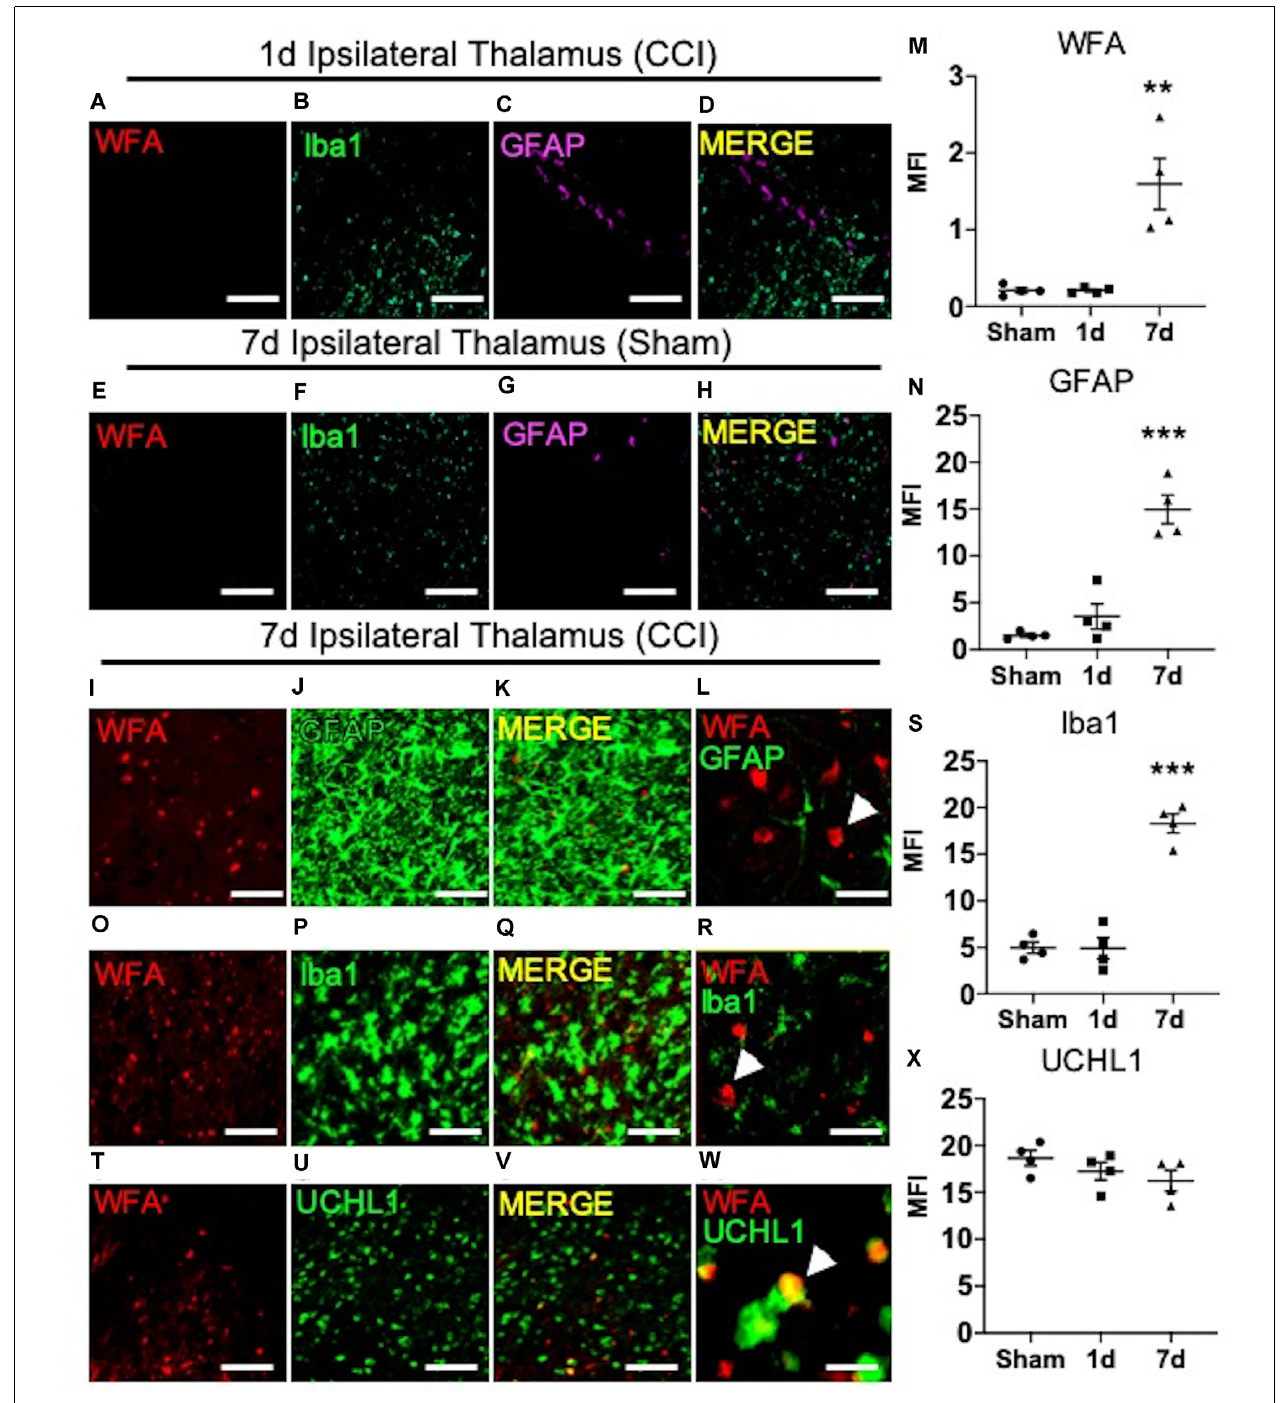
FIGURE 2 | The appearance of thalamic WFA + puncta moderately associates with UCHL1 + neurons 7 days post-CCI. Representative images of the ipsilateral thalamus at 1 day post-CCI show normal expression of WFA (A) , Iba1 (B) , GFAP (C) , and merged image (D) . Representative images of the ipsilateral thalamus at 7 days after the sham procedure show normal expression of WFA (E) , Iba1 (F) , GFAP (G) , and merged images (H) . The appearance of ipsilateral thalamic WFA + puncta (I,O,T) occurred in association with astrogliosis (GFAP, J ; merged image K,L ; quantified in M and N ), microgliosis (Iba1, P ; merged image Q,R ; quantified in S ), and UCHL1 + neurons ( U ; merged image V,W ; quantified in X ). High magnification image shows that GFAP (L) , Iba1 (R) , and UCHL1 (W) weakly colocalized with WFA + puncta in the thalamus ( white arrow demarcates WFA + puncta ). One-way ANOVA Dunnett’s post hoc test (M,N,S,X) . Values represent means ± SD ( n = 4, ** P < 0.01 ; *** P < 0.001 ). Scale bars = 200 µ m (A–K,O–Q,T–V) and 20 µ m (L,R,W) . WFA, wisteria floribunda agglutinin; UCHL1, ubiquitin C-terminal hydrolase L1; MFI, mean fluorescent intensity; CCI, controlled cortical impact; GFAP, Glial fibrillary acidic protein.